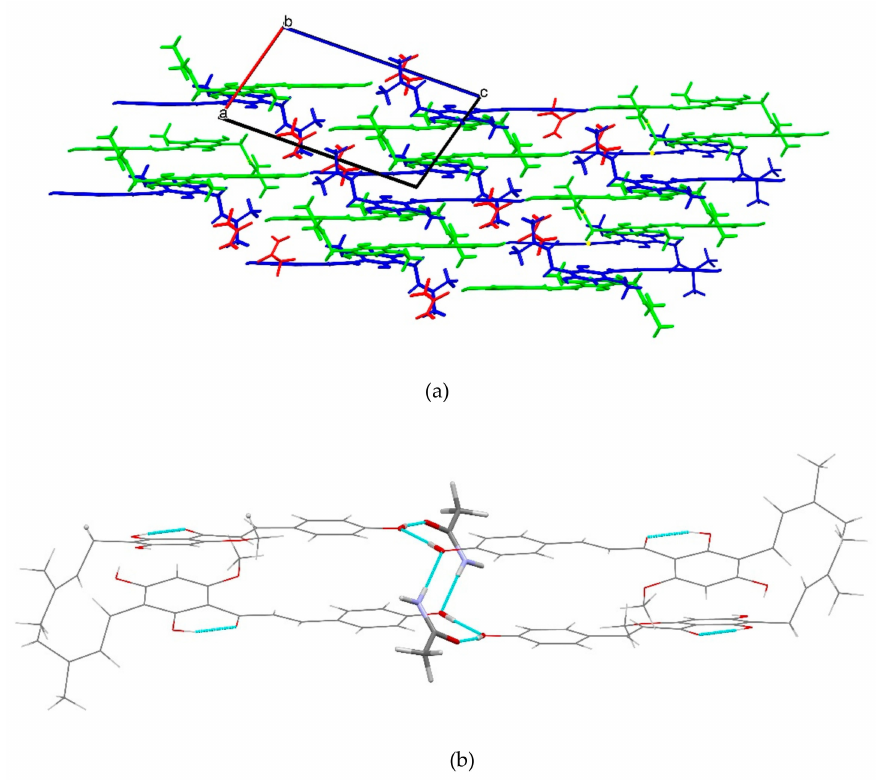
Figure 8. ( a ) Layers composed of A (blue) XN and B (green) XN molecules bonded by acetamide (red); ( 16 ) supramolecular rings. ( b ) XN layers linking the R 6 6